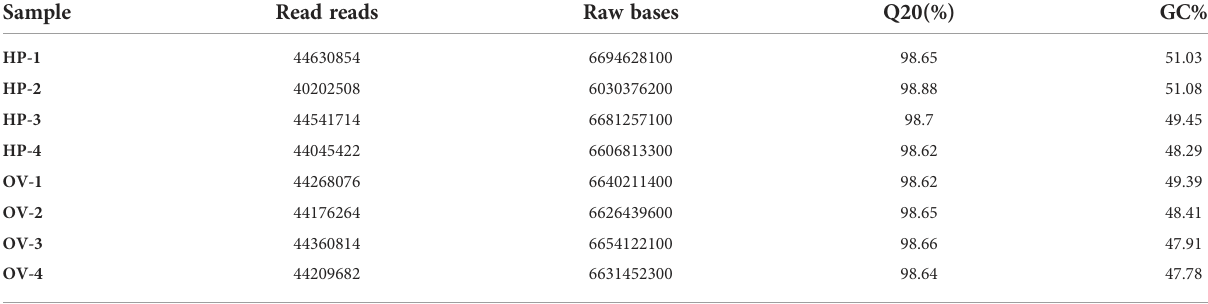
TABLE 2 Quality control and data statistics for clean reads.